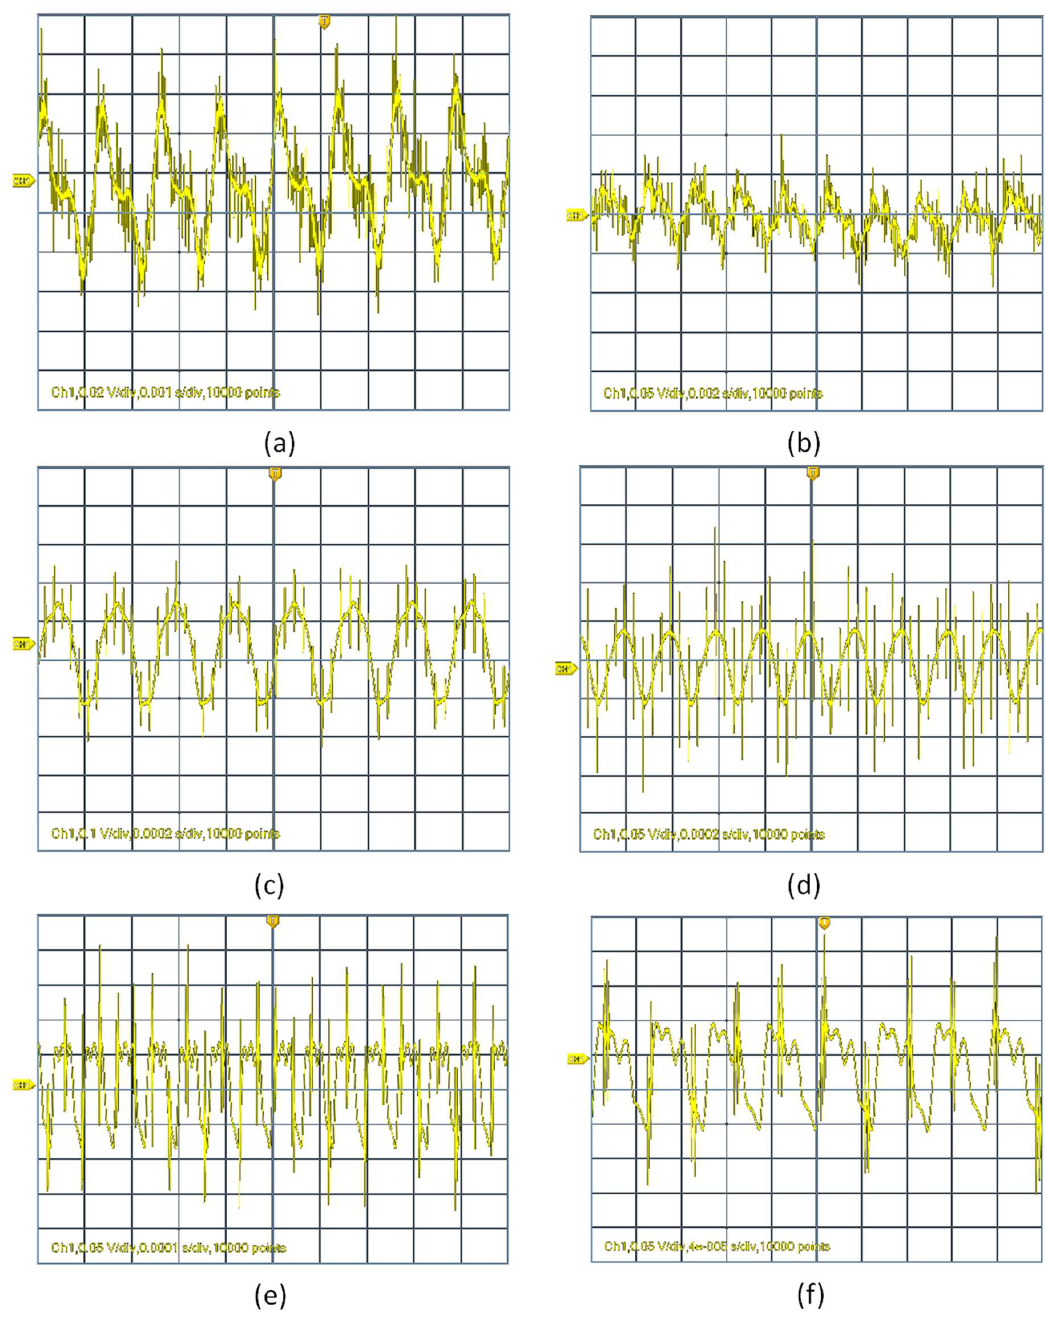
Figure 8. Examples of retraced acoustic wave signals at different input frequency at an applied voltage of 4.8 Volt. The used frequencies are, ( a ) 300 Hz, ( b ) 500 Hz, ( c ) 4 kHz and ( d ) 5 kHz. ( e ) represents the output signal voltage obtained for a frequency of 15 kHz and ( f ) 20 kHz. All wave signal graphs have a y-axis of voltage (in volts) and x-axis of time (in seconds). For relatively low-amplitude sound waves, the output signal was not distorted by much compared to higher amplitudes. However, at lower frequencies in the range of 100 to 800 Hz and for higher frequencies ranging from 10 to 20 kHz, the output signal was affected by distortion even at lower amplitudes. While at low-amplitude sound waves in the medium range, frequencies from 1 to 8 kHz had no distortion compared to other frequencies. Here in the case of medium range frequency,